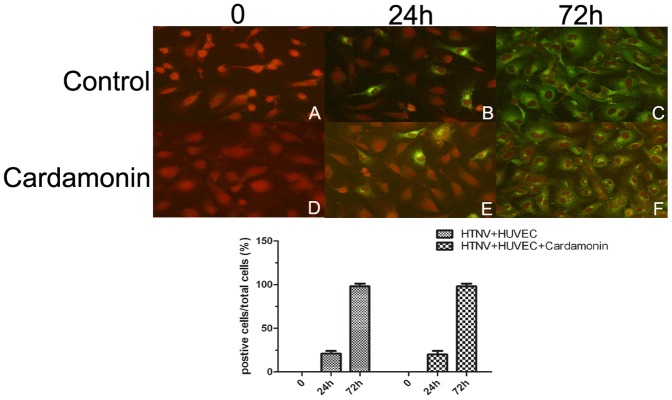
Detection of HTNV infection efficiency in HUVECs with or without cardamonin treatment (CD).The upper panel: A, normal HUVECs without any treatment; B, HUVECs infected with HTNV for 24 hours; C, HUVECs infected with HTNV for 72 hours. D, E, F, HUVECs pretreated with 30 μM cardamonin for 30 min before HTNV infection; D, cardamonin-pretreated HUVECs; E, cardamonin-pretreated HUVECs infected with HTNV for 24 hours; F, cardamonin-pretreated HUVECs infected with HTNV for 72 hours. Original magnifications, ×200. Lower panel: data are shown as the ratio of positive cells/total cells from five independent microscopic fields.